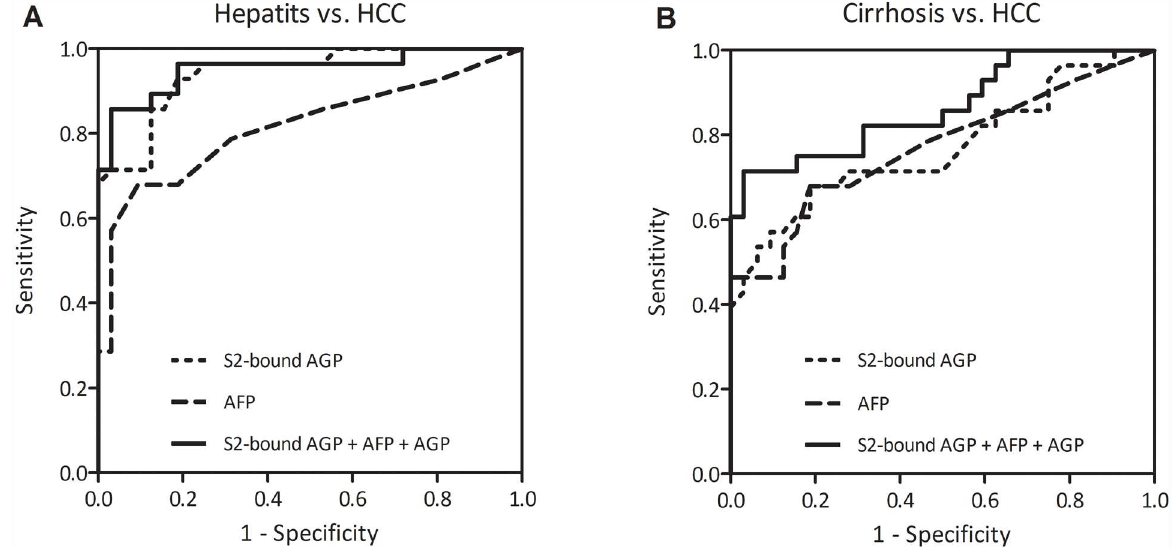
Fig 7. ROC-analyses of S2-bound AGP, AFP and a combination of S2-bound AGP, AFP and AGP to differentiate HCC from hepatitis (panel A) and HCC from cirrhosis (panel B).